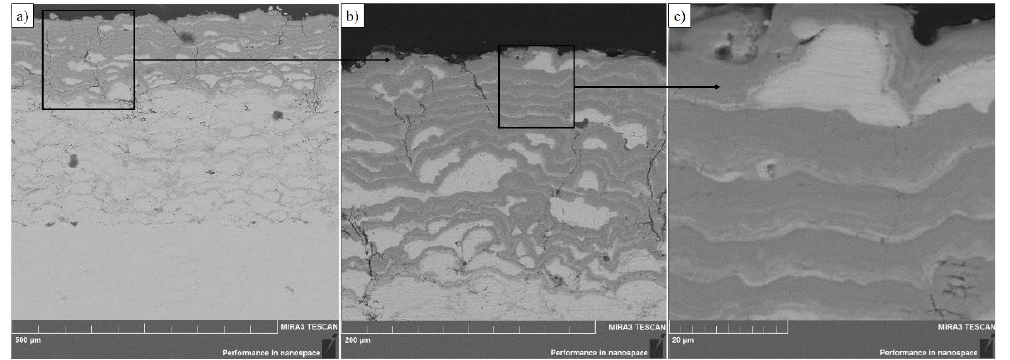
Figure 6. Microstructure of the cross section of the coating with gradient structure. Microstructure of ×250 ( a ), ×3000 ( b ), and ×5000 ( c ).